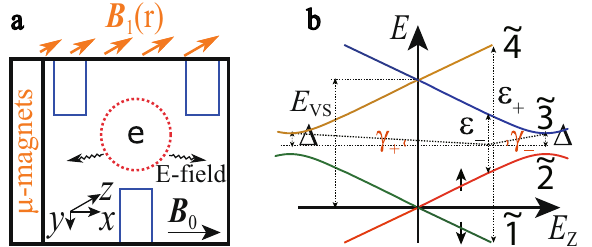
Fig. 1 Schematics diagrams. a Schematic diagram of an electron spin qubit in a gate-de fi ned QD in the presence of micromagnets. An external magnetic fi eld is applied along the x -axis and polarizes the micromagnets. A uniform magnetic fi eld B 0 is along the x -axis, and a slanting magnetic fi eld B 1 ( r ) indicated by orange arrows is along the z -axis (orthogonal to the xy plane). The slanting fi eld gives rise to a synthetic SOC, which mixes the spin states and valley states. The electric fi eld from phonon or photon leads to spin decoherence or spin manipulation via the synthetic SOC. b The energy level diagram of the mixed spin-valley eigenstates as a function of the Zeeman splitting E Z . The SOC couples the spin-valley product states and results in the eigenstates (denoted as numbers with tildes). The mixing angles γ ± are indicated, where tan γ ± is proportional to the splitting Δ due to SOC and inversely proportional to the energy detuning ε ± . The broken T -symmetry of the synthetic SOC determines the relative phases of the mixings and leads to constructive interference for spin